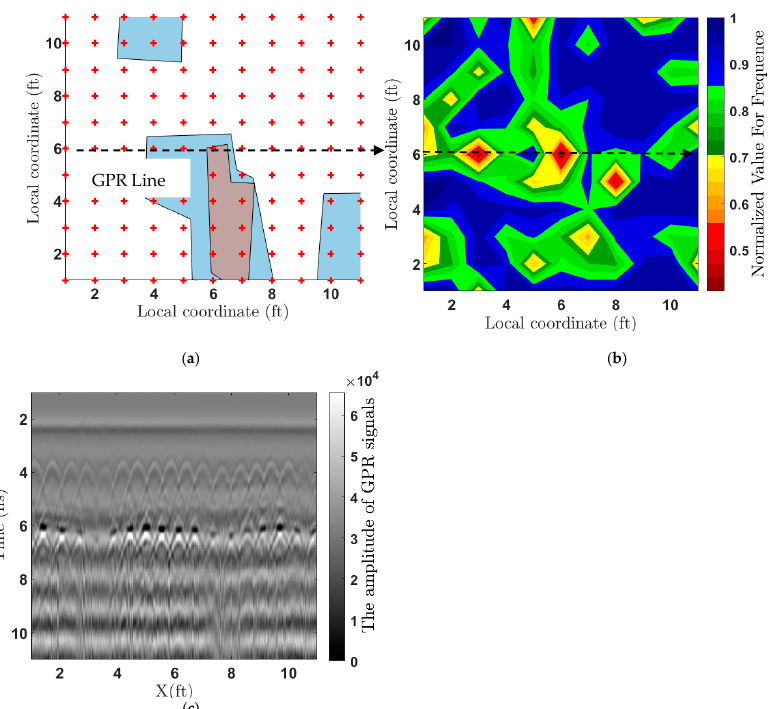
Figure 16. FR NB origin D ( a ) ground truth, ( b ) frequency approach, and ( c ) B scan of the GPR profile (local coordinate Y = 6).